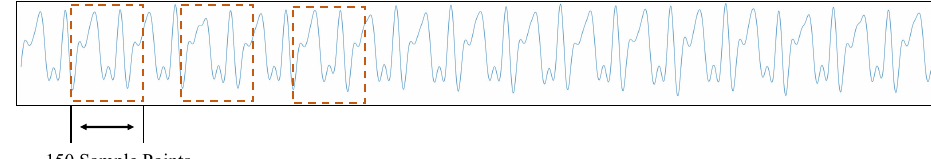
Figure 8. Sliding window.